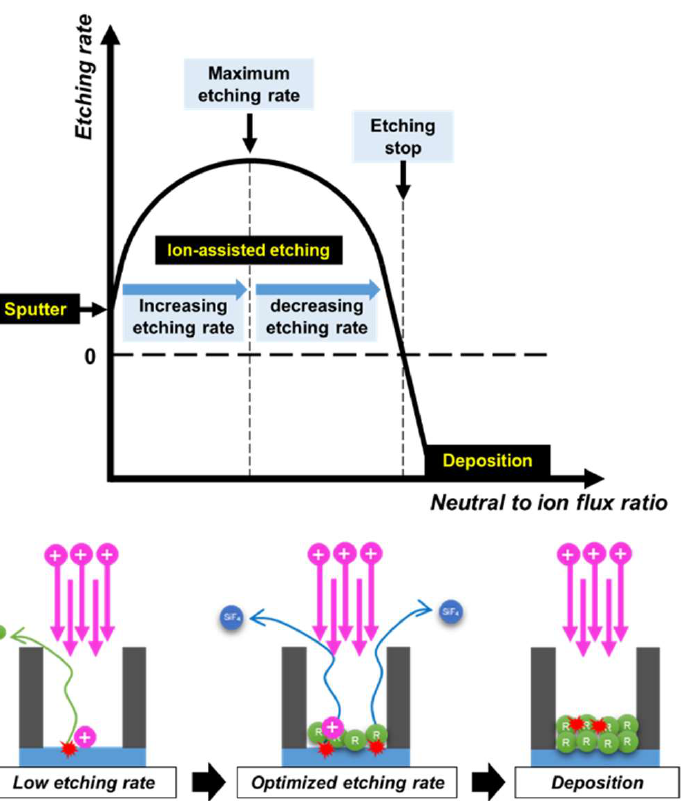
Figure 2. Illustration of etching regimes regarding different neutral to ion flux ratios with fixed ion energy.